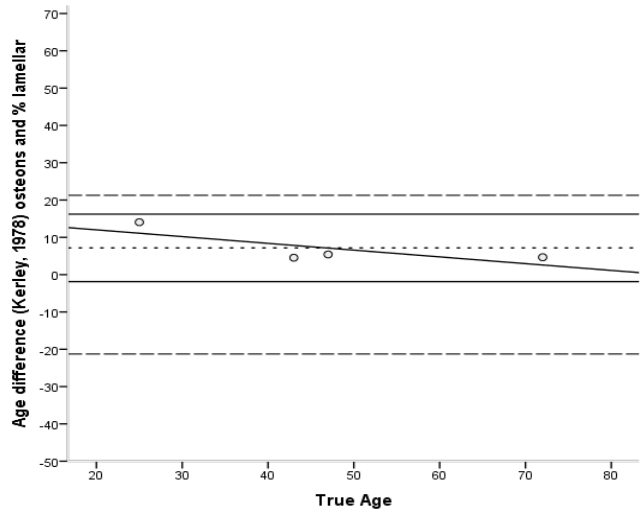
Figure 8. Bland–Altman plot for Kerley’s [33] intact osteon and % lamellar bone equations average value illustrating the differences between known and estimated ages for the femora against the known age. Depicted are 95% limits of agreement (black horizontal lines), mean difference/bias (black dotted line), best fit lines and 95% confidence intervals of the SEE for each method (dashed lines). R 2 of the best fit line: 0.579.